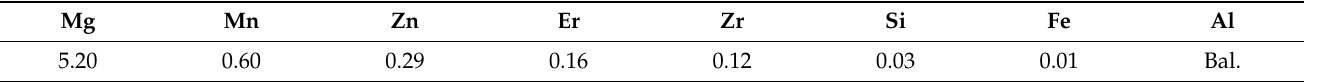
Table 1. Chemical compositions of experimental alloy (wt.%).